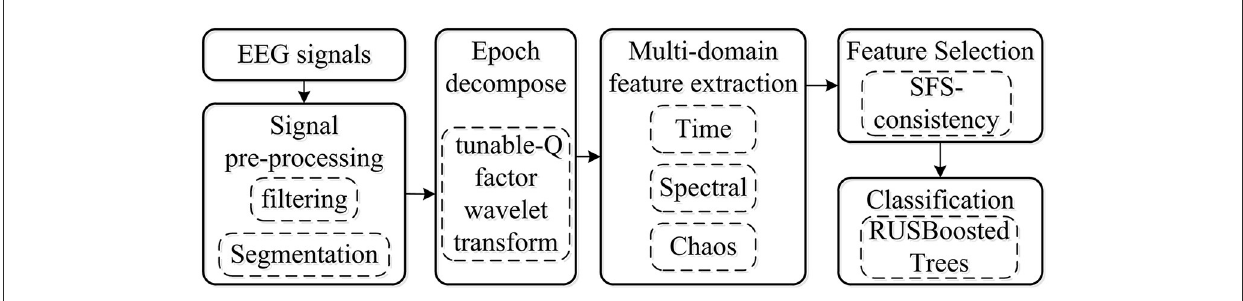
FIGURE1 Schematic outline of the proposed computer-assisted k-complex detection scheme.